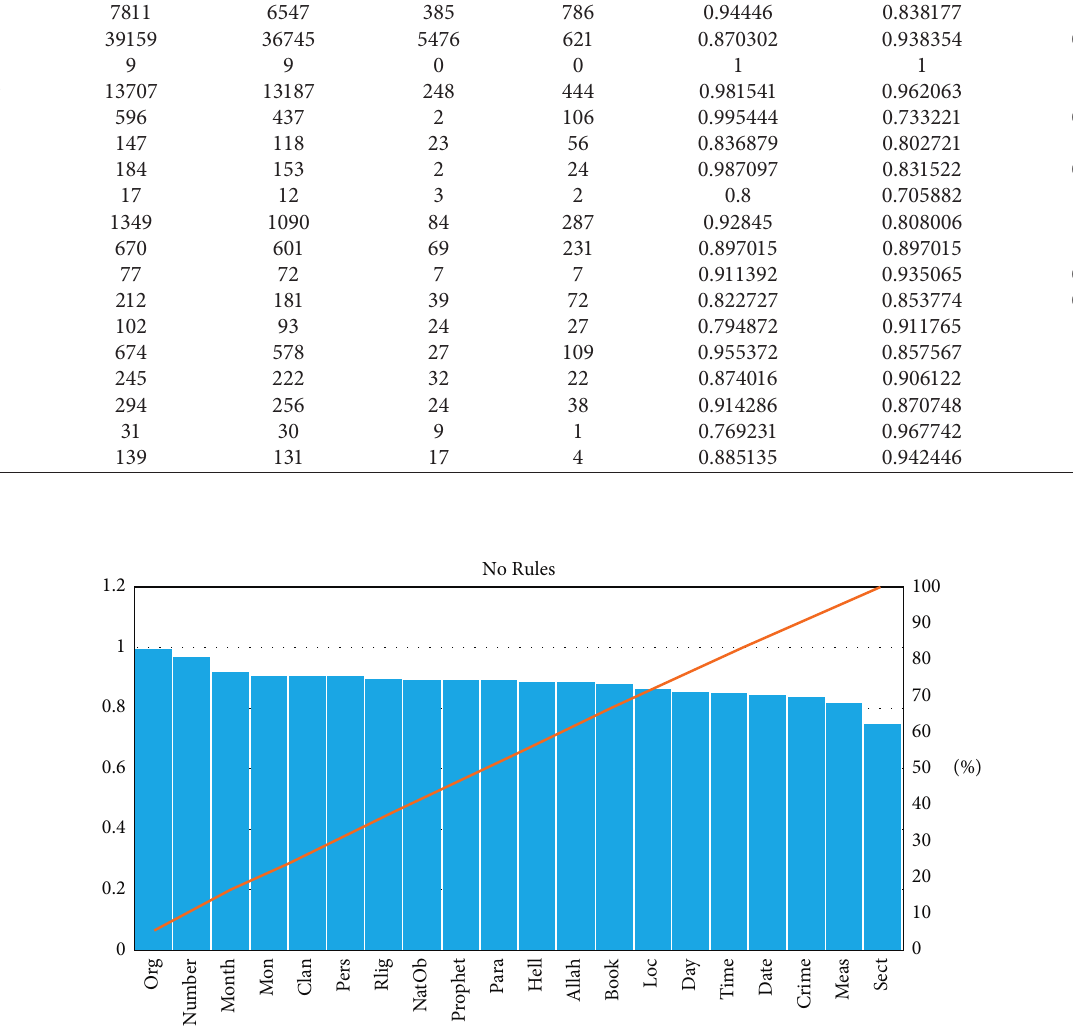
Figure 9: Results of not using grammar